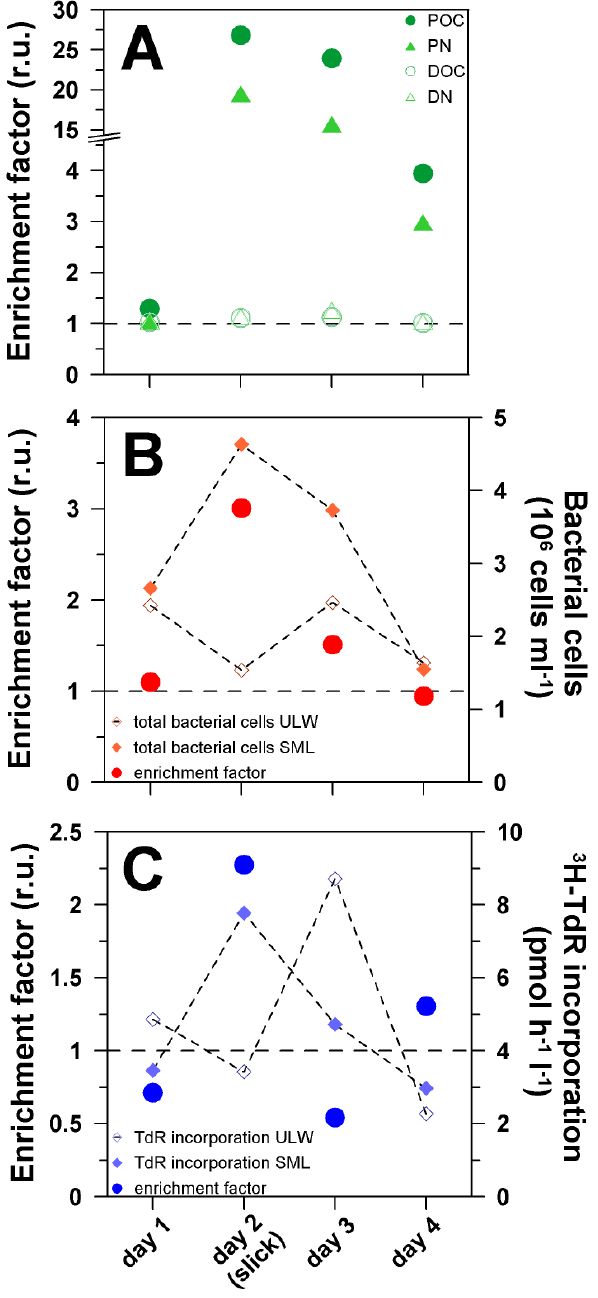
Fig. 1. Changes of organic carbon and nitrogen (A) , bacterial abundance (B) , and bacterial incorporation of 3 H-thymidine (C) throughout the formation and disintegration of a visible surface film (slick) in the southern Baltic Sea. Values are given as enrichment factors (EF), i.e., relative ratios between the sea-surface microlayer and the underlying water. Dashed lines indicate EF=1, in which case the values in the samples were equal. Additionally, absolute values for the bacterial parameters are